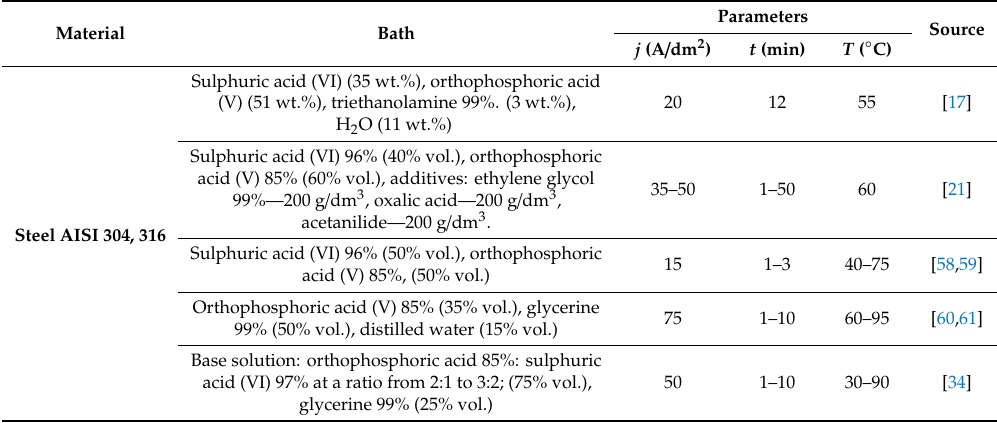
Table 1. Sample baths and parameters of the electrochemical polishing process of stainless steel.